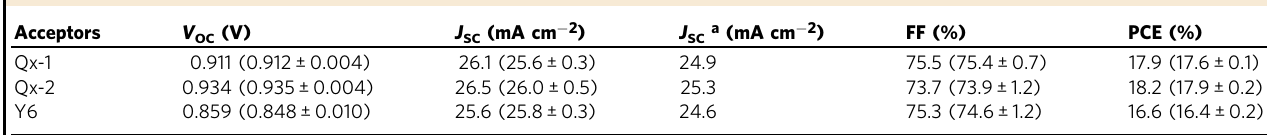
The average parameters were obtained from 30 independent devices. The error bars correspond to the standard deviation of 30 independent devices. a The calculated J SC values from the EQE